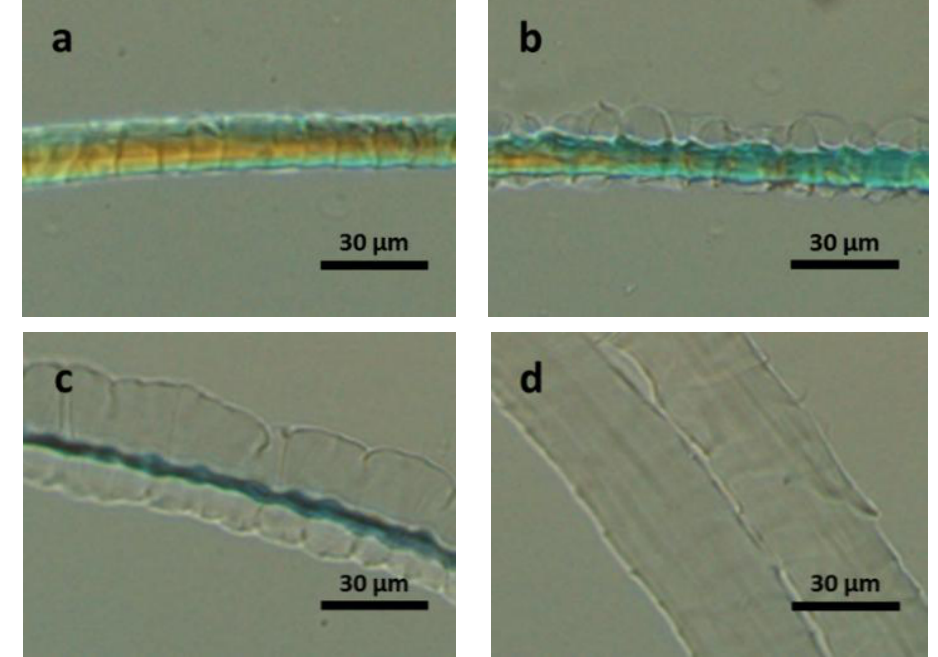
Figure 4. POM images of thioglycolic acid (TGA) pretreated wool fibre dissolving in [Bmim]OAc at 120 °C for: ( a ) 0 s; ( b ) 5 s; ( c ) 15 s; and ( d ) 30